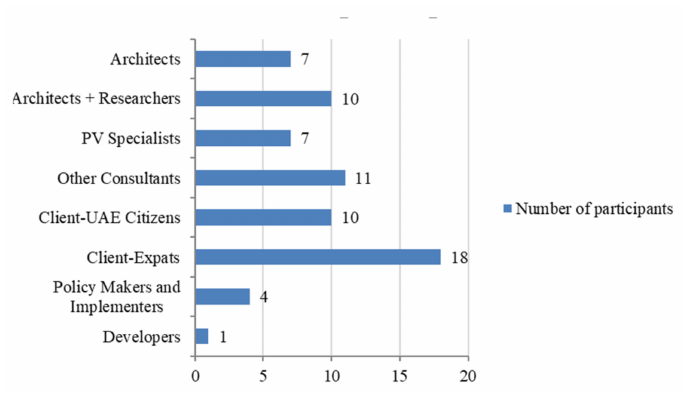
Figure 2. Breakdown of study participants by stakeholder